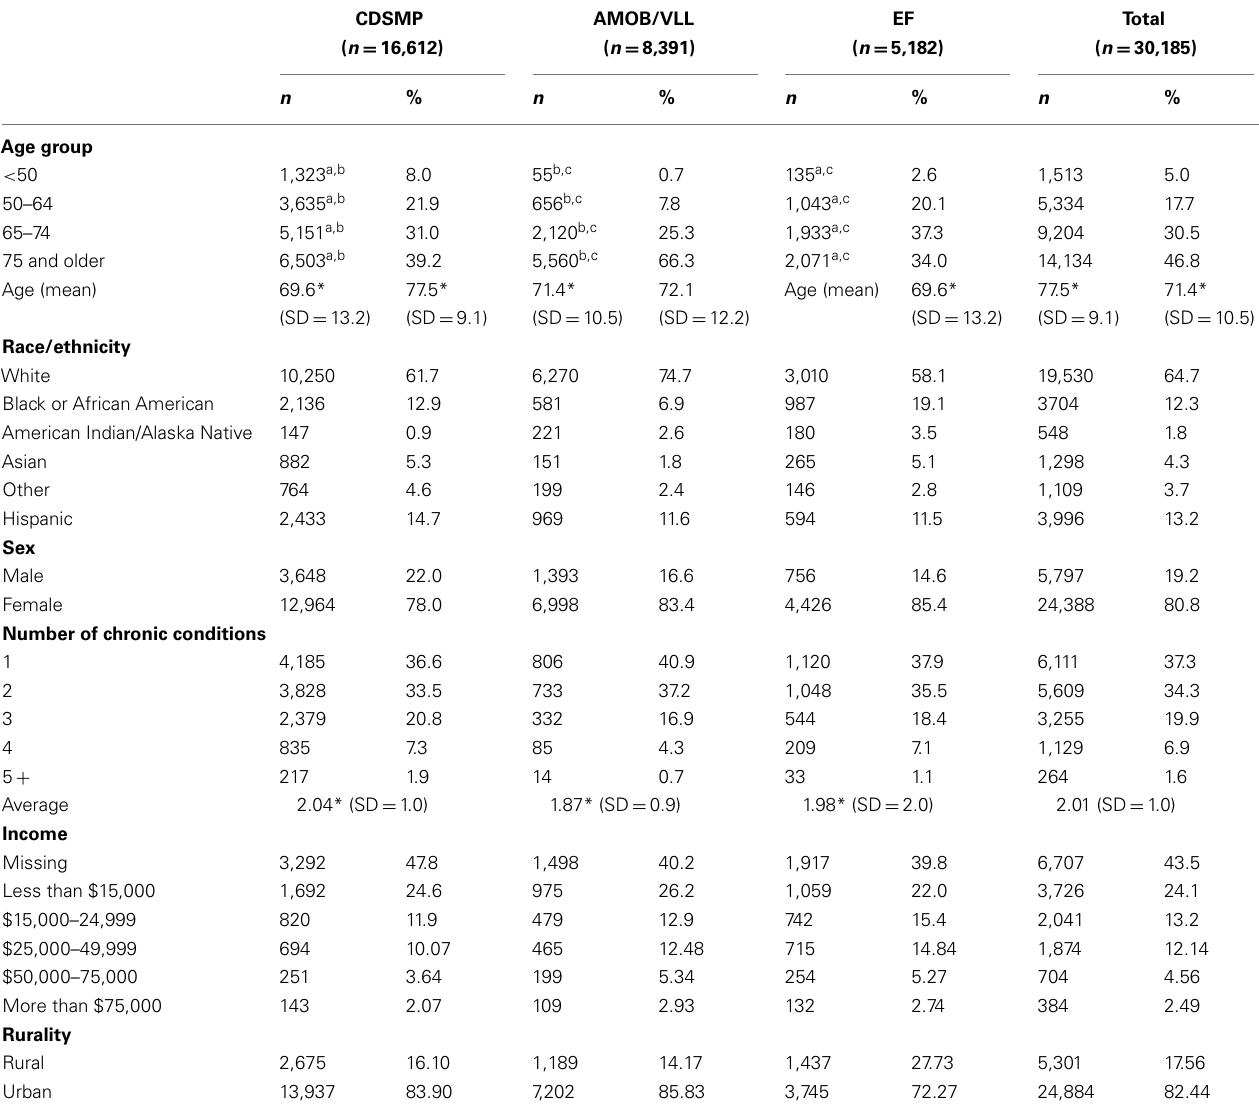
Table 1 | Distribution of participant characteristics by program